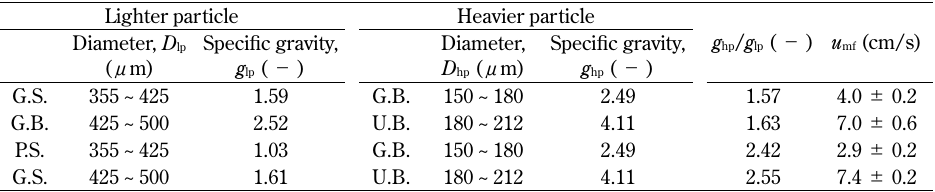
Table 4 Characteristics of fluidized particles for various g hp / g lp experiments Lighter particle